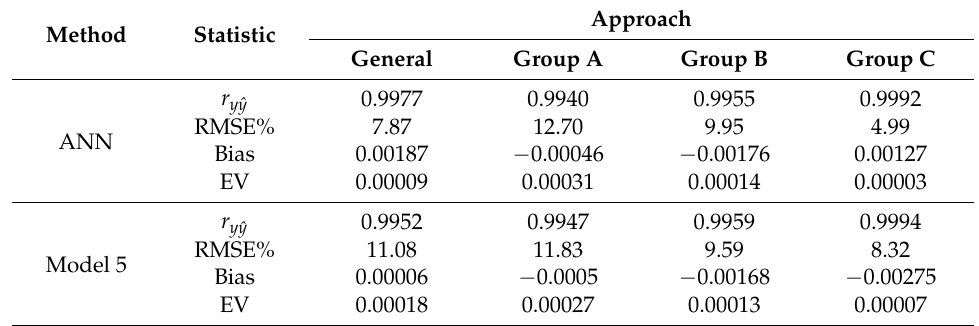
Table 5. Correlation coefficient ( r yˆy ), root mean square error (RMSE%), bias, and error variance (EV) of the artificial neural networks and equations with Model 5 in scenario